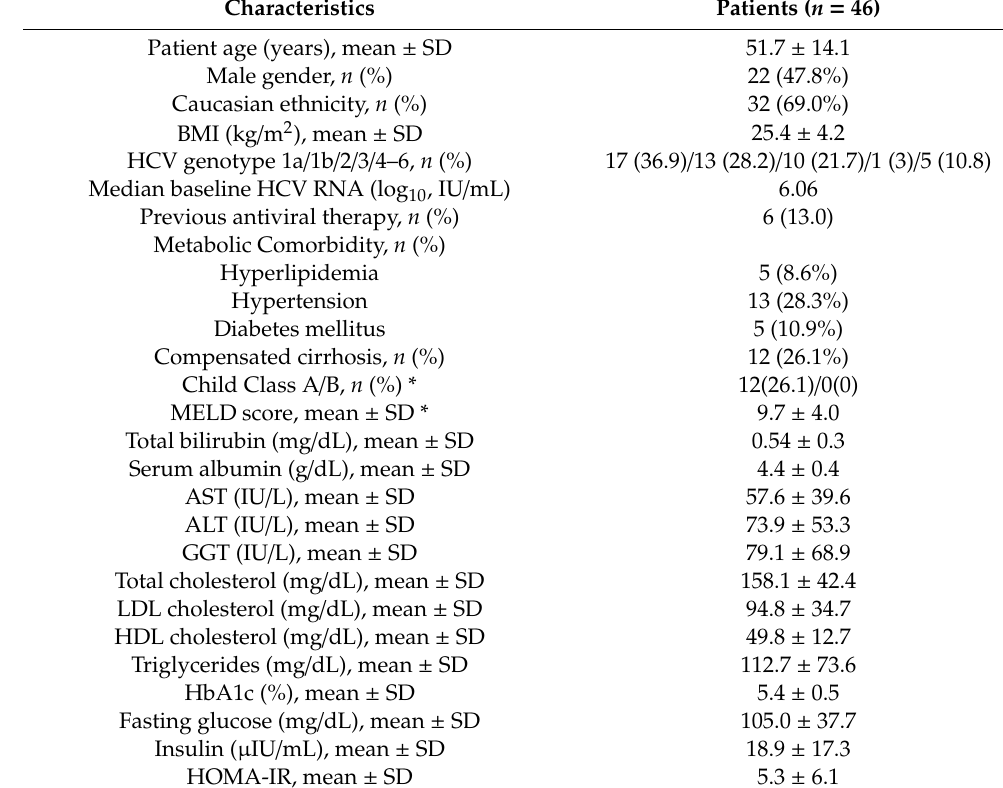
Table 1. Baseline patient